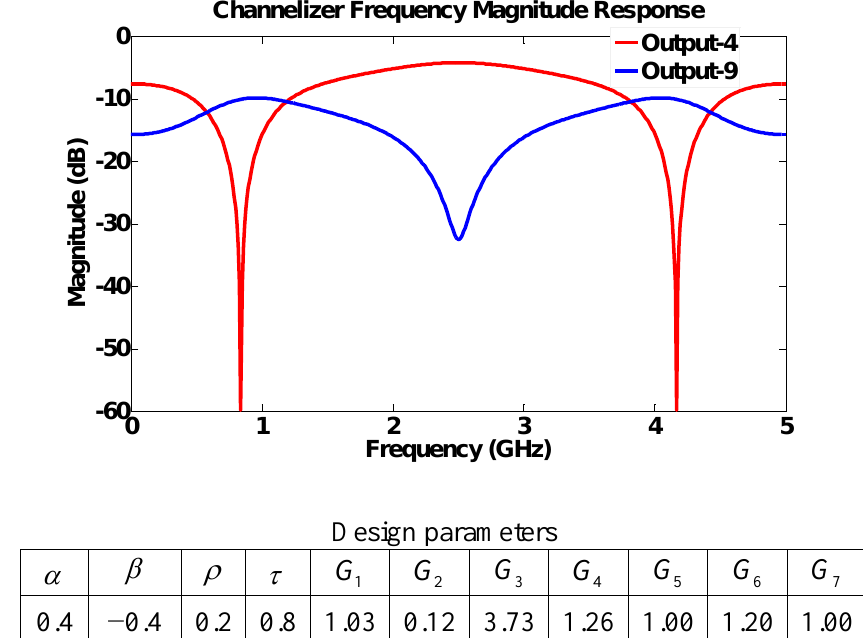
Figure 14. Frequency response for structure IV using high transmission parameters.